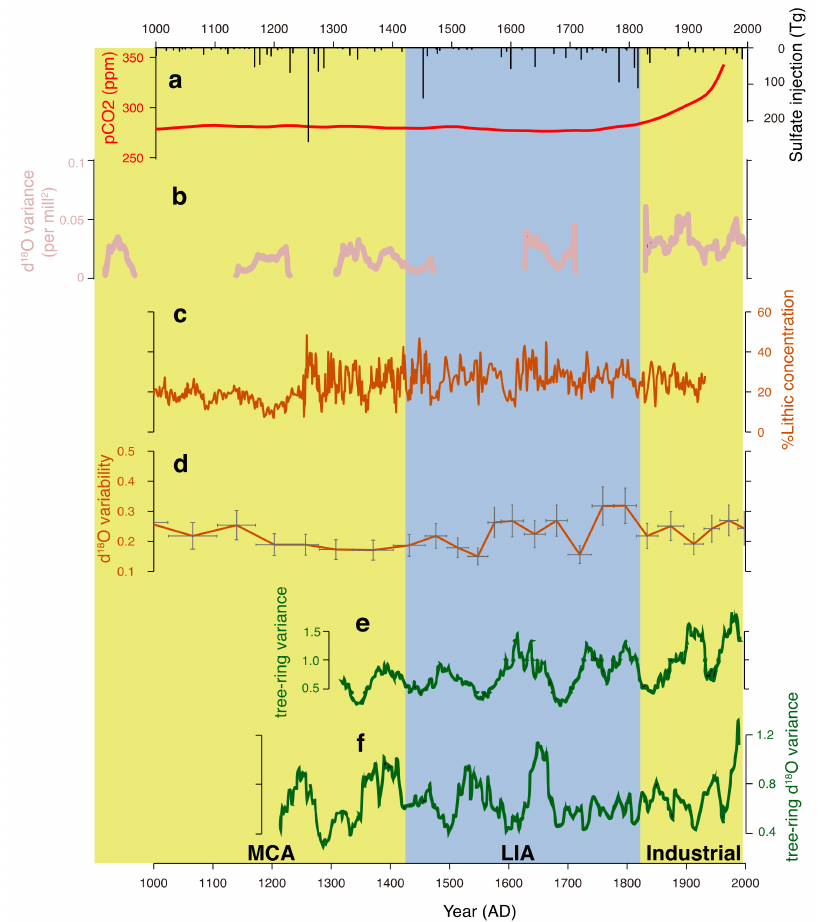
Figure 2. Time series of external forcings and ENSO variability revealed by proxy reconstructions (with the corresponding colors to Figure 1) since the last millennium. ( a ) CO 2 concentration (red) and global volcano activities (black) [72]; ( b ) Coral δ 18 O variability from the equatorial central Pacific [39], modified from Otto-Bliesner et al. [66]; ( c ) Lithic concentration in a marine sediment from off Peru (% of maximum) [27]; ( d ) δ 18 O variability from marine sediments from the tropical eastern Pacific [32]; ( e ) Tree-ring synthesis from circum-Pacific sites (modified from Li et al. [36]); ( f ) δ 18 O variability in tree-ring from Taiwan (modified from Liu et al. [37]). Vertical bars denote the Medieval Climate Anomaly (MCA), the Little Ice Age (LIA) and the industrial warming,